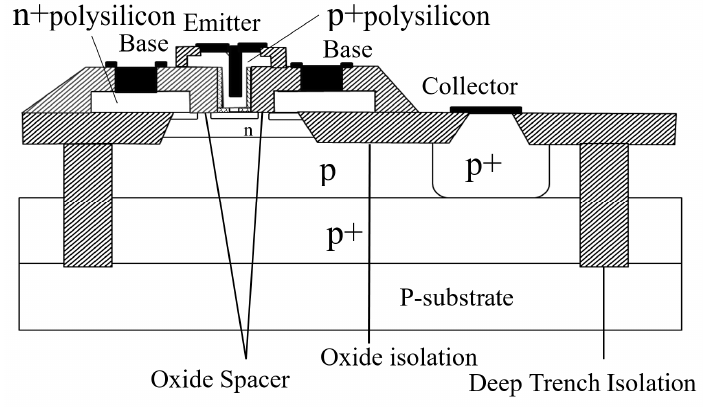
Figure 1. The cross-section of theDPSA BJT.